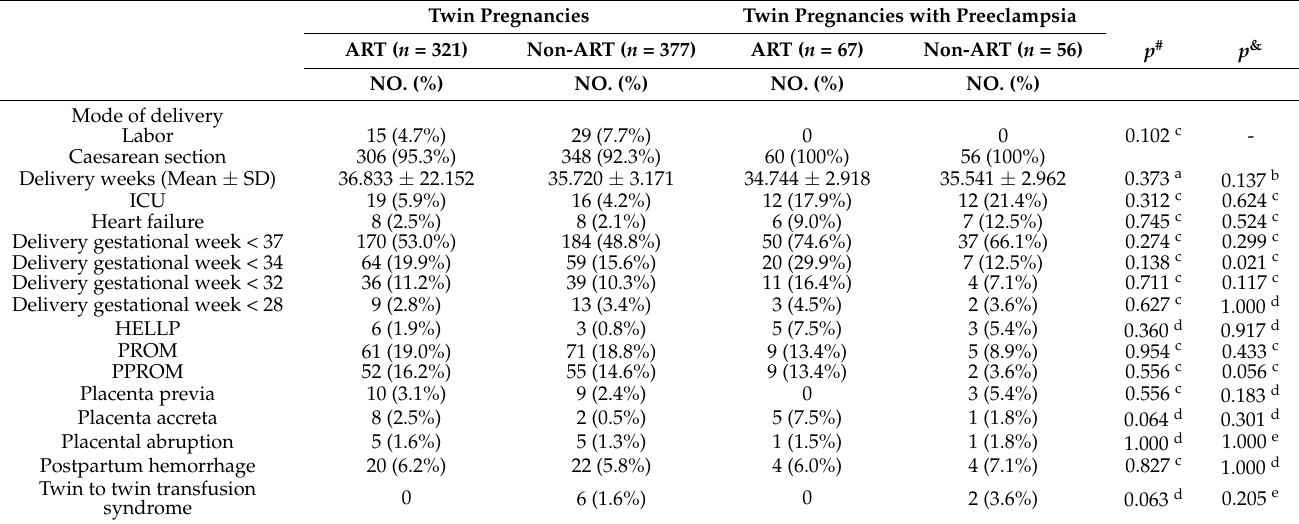
Table 4. Maternal outcomes of twin pregnancies with preeclampsia and their association with ART.